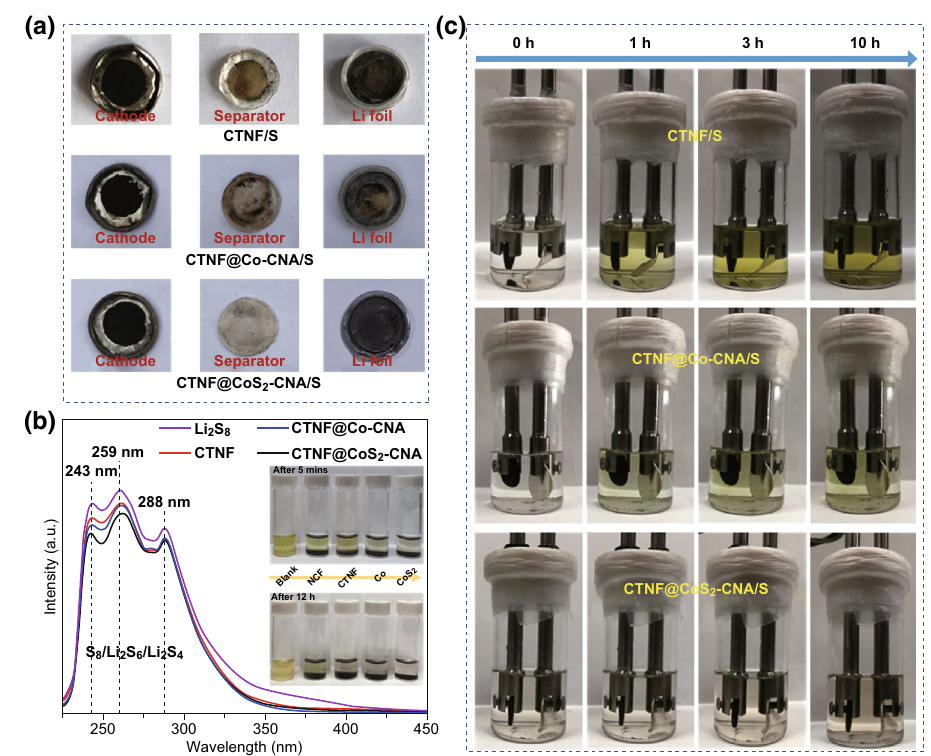
Fig. 7 a Digital photographs of CTNF/S, CTNF@Co–CNA/S, and CTNF@CoS 2 –CNA/S cells after cycling at 1 C. b UV–Vis absorption spec- tra of various Li 2 S 8 solutions, and the insets show the optical photographs of Li 2 S 8 solutions before and after 12 h contact with the NCF, CTNF, CTNF@Co–CNA, and CTNF@CoS 2 –CNA materials, respectively. c Beaker cell tests of three